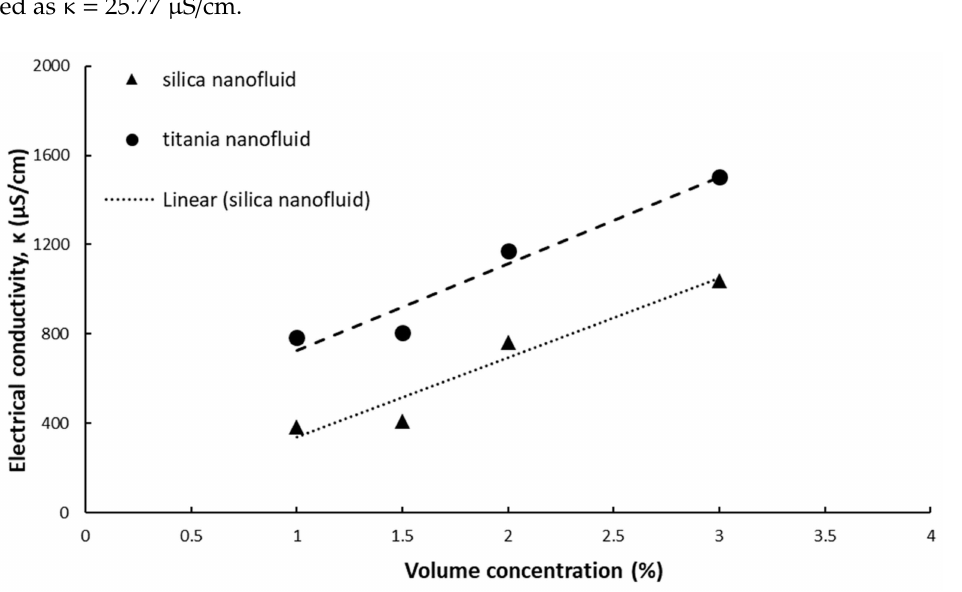
Figure 1. Experimental results on simple nanofluids at ambient